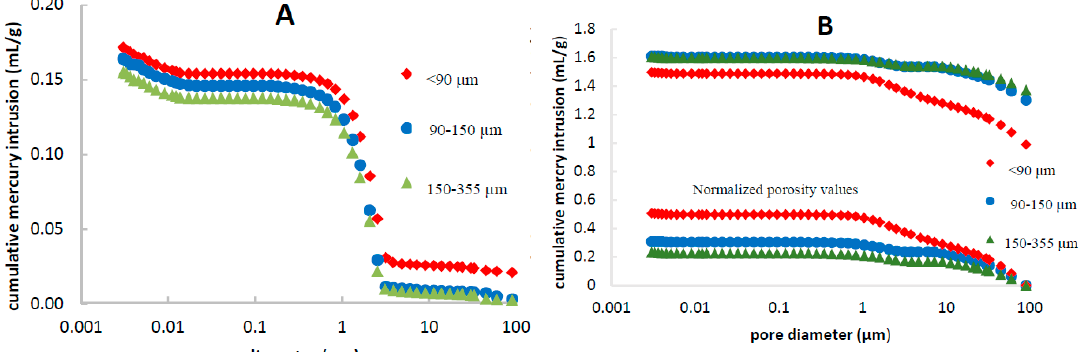
Figure 2. Cumulative mercury intrusion of USAC tablets with different drug particle sizes, before ( A ) and after drug release study ( B ), with normalized porosity values—without initial mercury intrusion—represented at the bottom of the image.